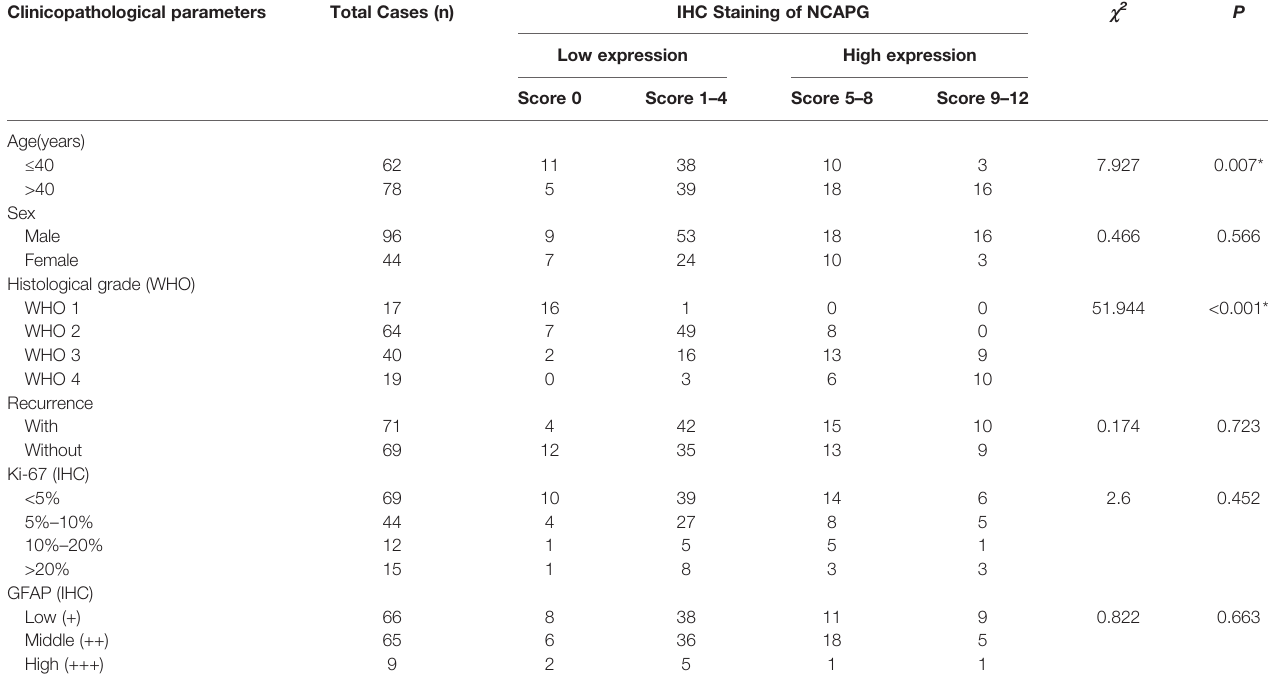
Signi fi cant P-values are shown in italics, *P < 0.05.